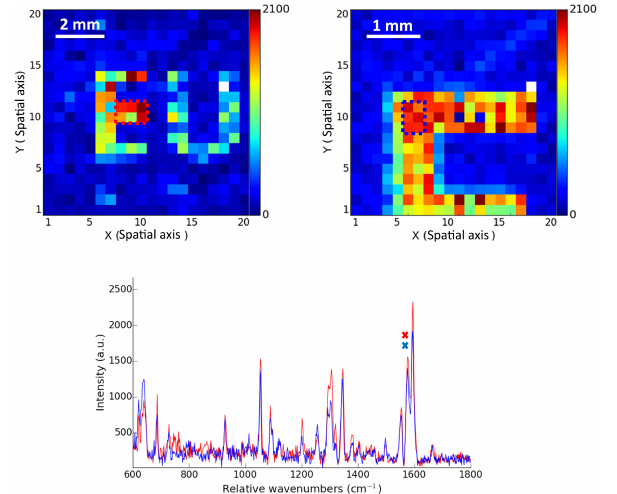
Figure 10. Comparison of AO1 and the MLA-based AO2 by recording Raman images of the lettering “EURO” printed on a EUR 10 bill. Upper left: pseudo color Raman image of a part of the “E” achieved with AO1. Upper right: pseudo color Raman im- age of the letters “EU” achieved with AO2. Both Raman images are based on the intensity at 1576cm − 1 , which corresponds to the distribution of the printing ink. Below: average Raman spectra re- ceived from six pixels with AO1 (blue curve) and AO2 (red curve), respectively. The positions of the binned pixels are outlined with squares in the pseudo color images.